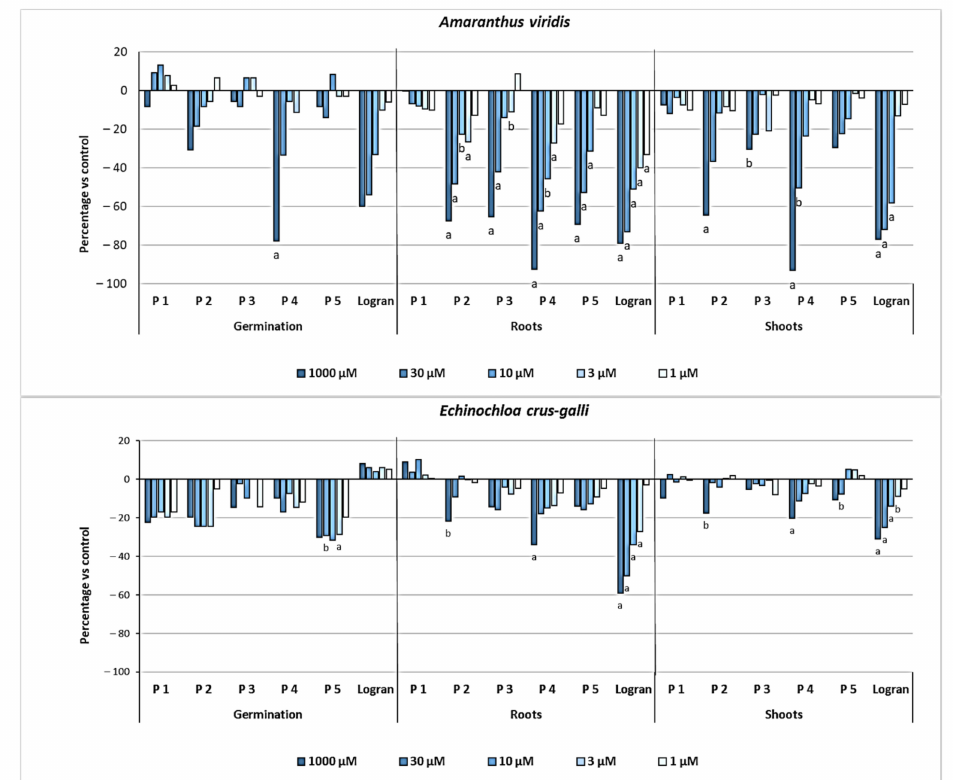
Figure 6. The effects of the compounds ( 1 – 5 ) obtainned from M. pulchrum leaves and of triasulfuron herbicide (Logran) on the germination and growth of weeds. Values are expressed as the percentage difference with respect to the control. Significance levels p < 0.01 (a) or 0.01 < p < 0.05